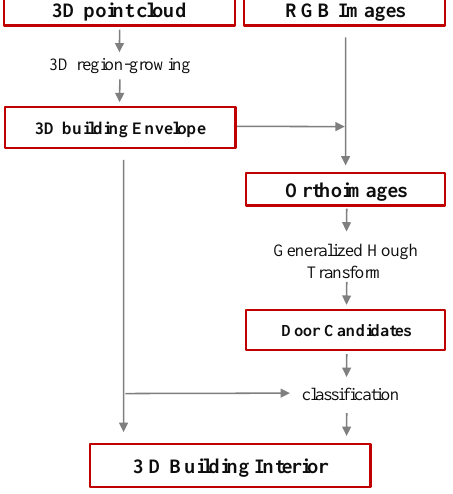
Figure 1. Workflow of the proposed